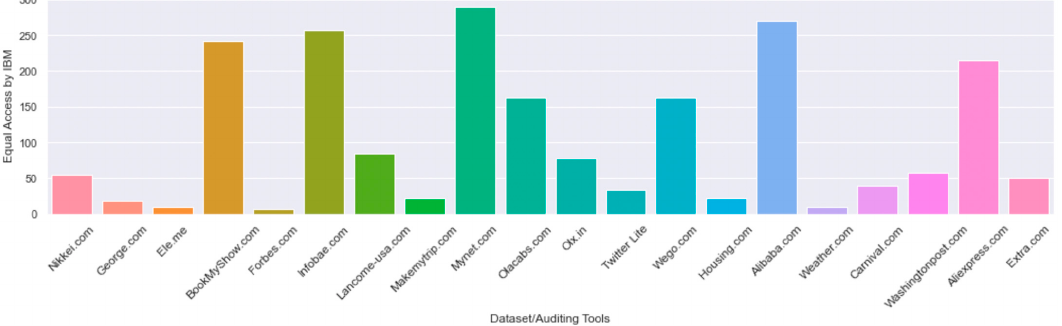
Figure 7. Equal Access by IBM (T9) errors for new technology (PWA) websites .